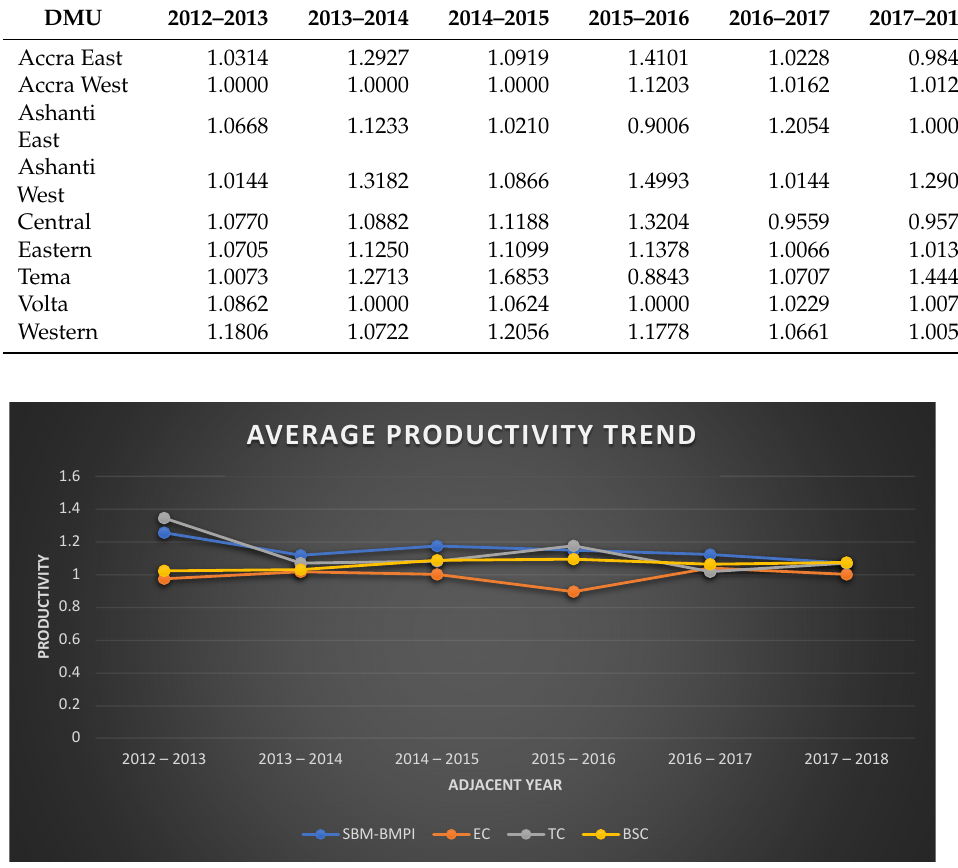
Figure 1. Average productivity trends for the period 2012 to 2018. Energies 2022 , 15 , x FOR PEER REVIEW